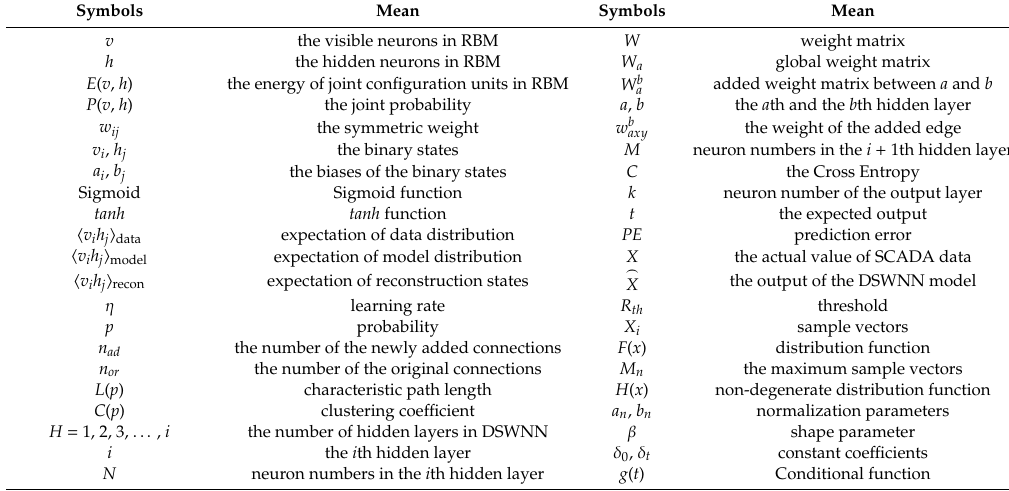
Table A2. Symbols